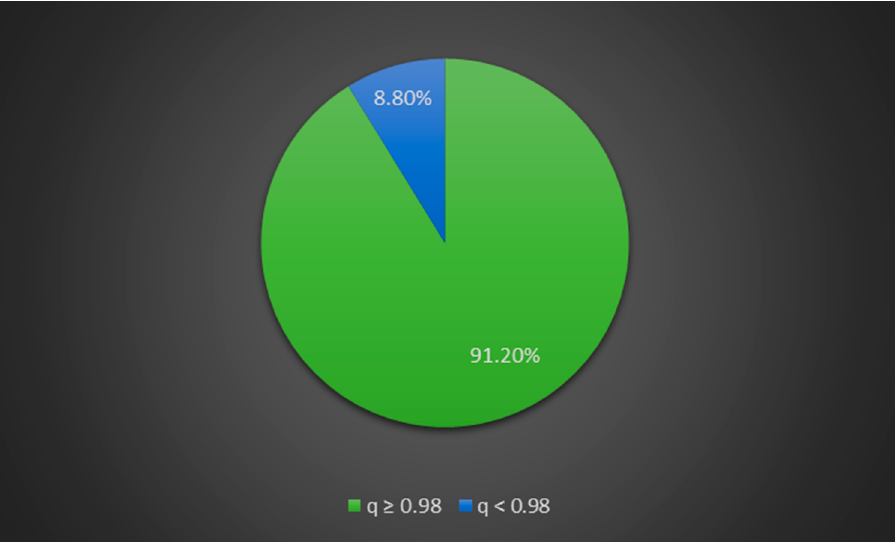
Figure 3. Percentage of pure-bred alpacas ( q ≥ 0.98) and alpaca × llama hybrids ( q < 0.98) across all tested alpacas. Table 2. q values of putative alpaca–llama